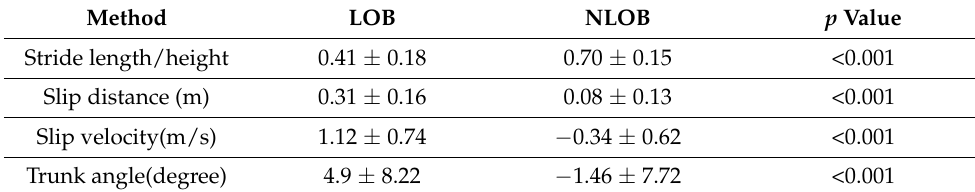
Table 1. Comparison of kinematic measures (mean ± standard deviation) between LOB trials and NLOB trials.